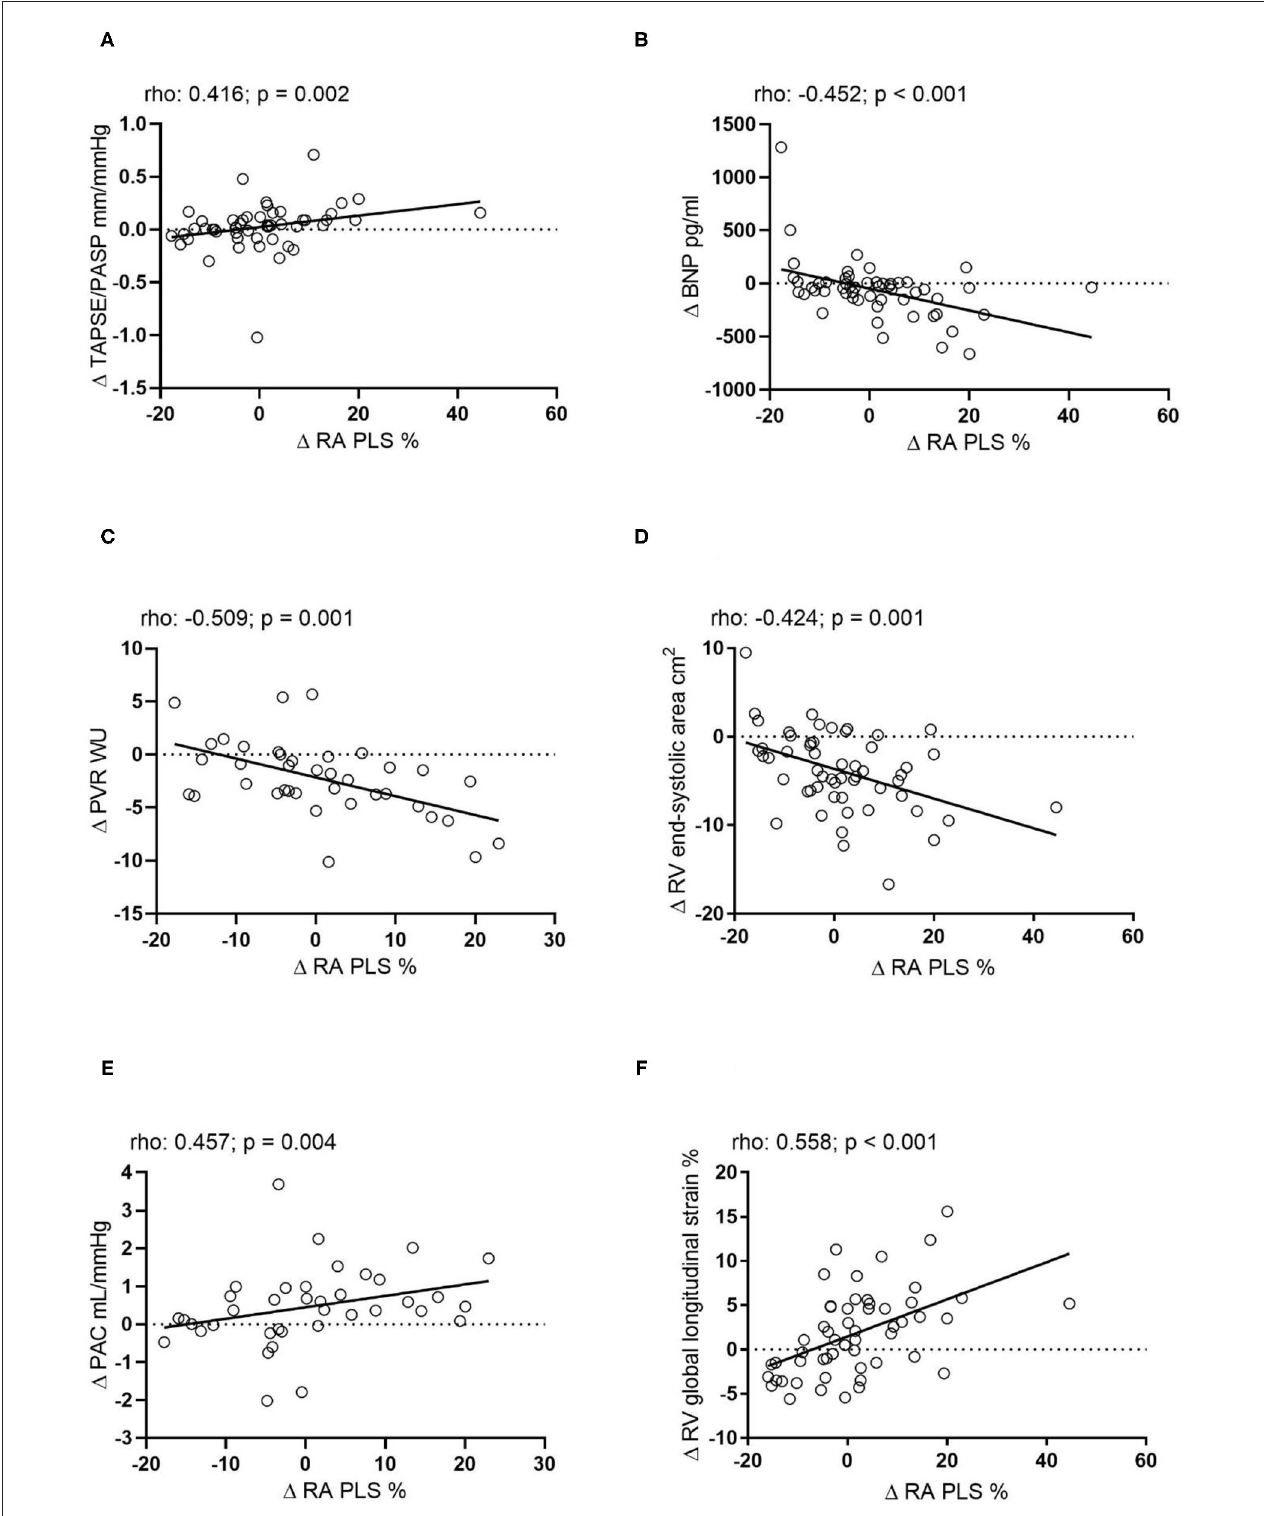
FIGURE 2 | Correlation of the absolute change of RA PLS during echocardiographic follow-up with the absolute change of (A) TAPSE/PASP ( n = 44), (B) BNP ( n = 54), (C) PVR ( n = 38), (D) RV end-systolic area ( n = 55), (E) PAC ( n = 38), and (F) RV global longitudinal strain ( n = 54). 1 , change; BNP, B-type natriuretic peptide; mPAP, mean pulmonary arterial pressure; PAC, pulmonary arterial capacitance; PASP, pulmonary arterial systolic pressure; PVR, pulmonary vascular resistance; RA PLS, right atrial peak longitudinal strain; RV, right ventricular; TAPSE, tricuspid annular plane systolic excursion; WU, Wood Units.